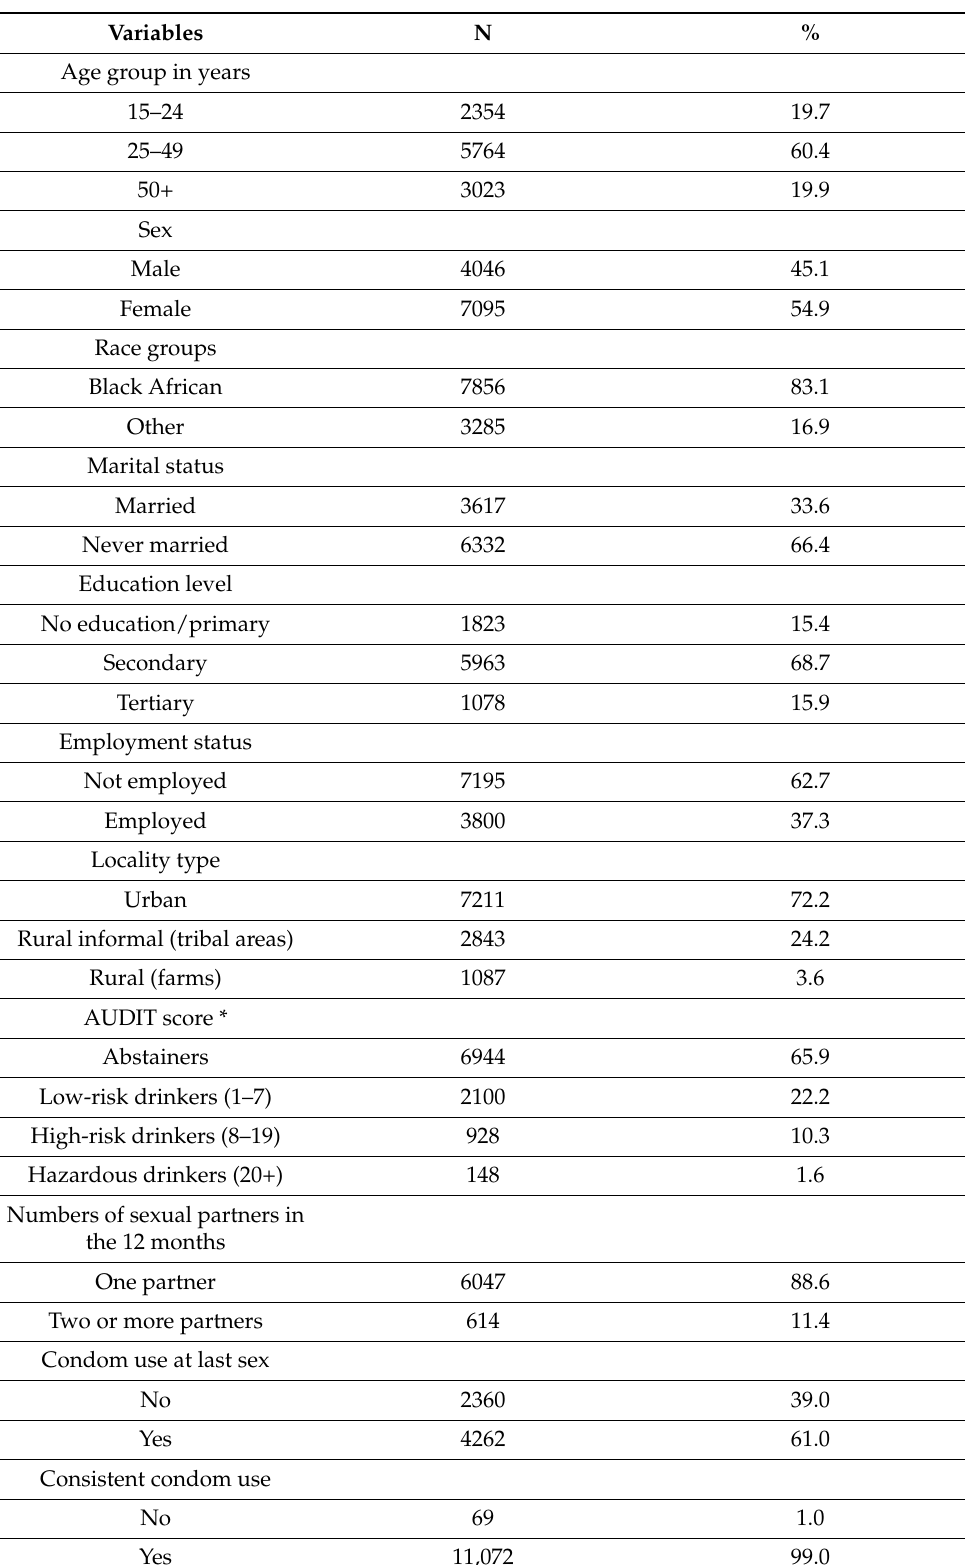
Table 1. Participant’s socio-demographic and behavioural characteristics of the study sample, South Africa 2017